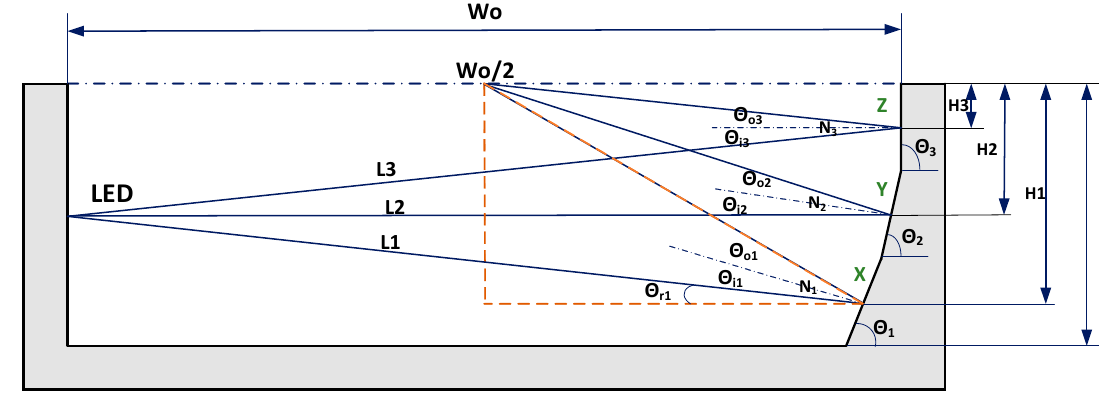
Figure 9. Geometry structure of ray tracing with VARS.